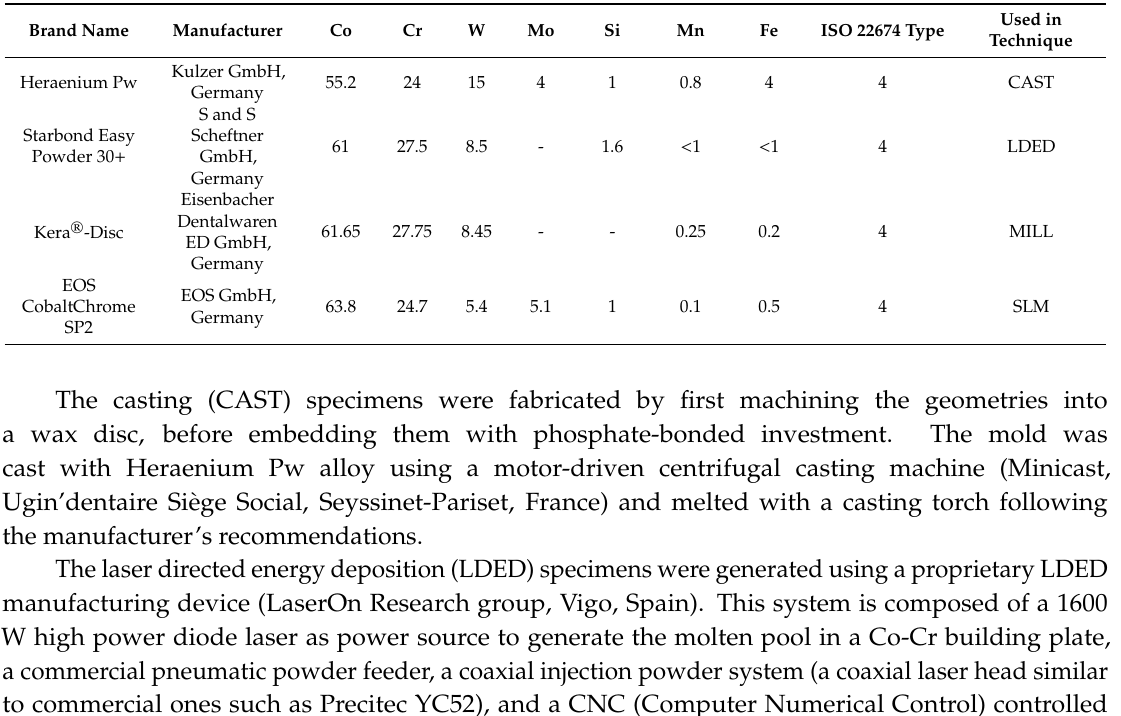
Table 1. Summary of the tested alloys composition, provided by the